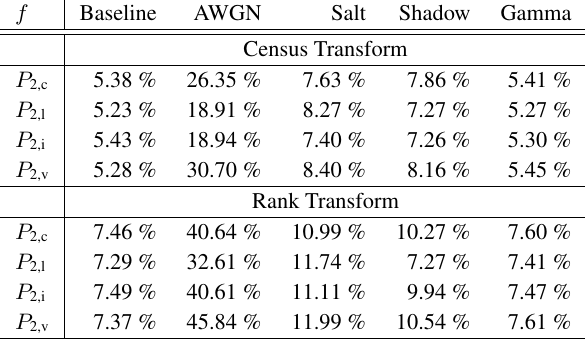
Table 2: Errors in non-occluded areas with a threshold of 1 dis- parity obtained with optimally parametrized penalty functions on the cones image under various types of